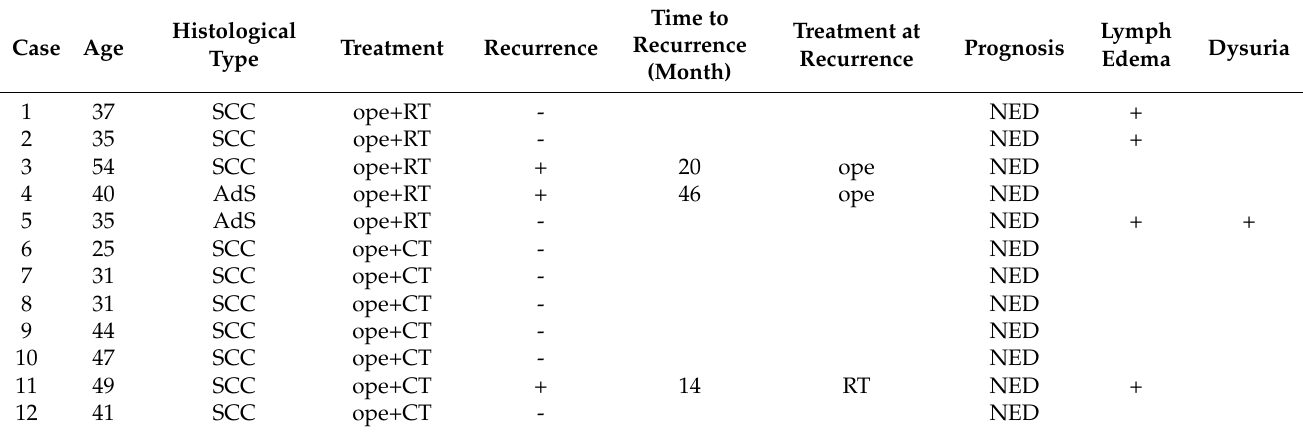
Table 1. Stage IIIC1 cases classified as T1 by the TNM classification of the Union for International Cancer Control.